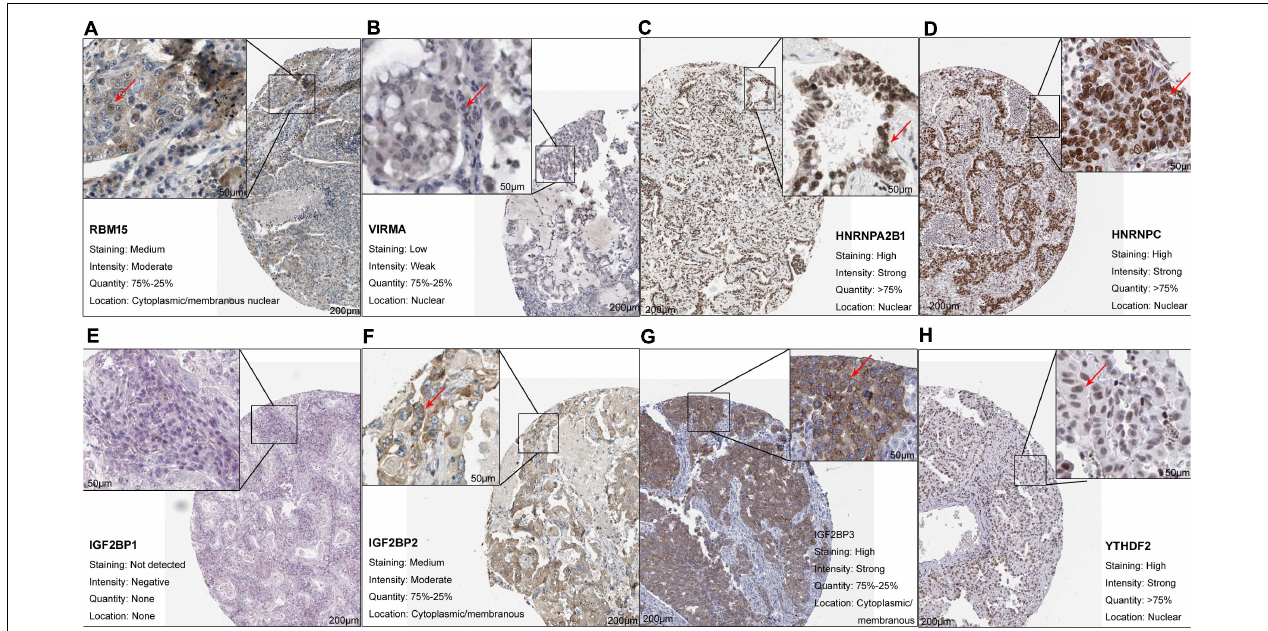
FIGURE 2 | Upregulation of m6A-related genes in lung adenocarcinoma. (A) RBM15 (antibody CAB015201, patient 3003), (B) VIRMA (antibody HPA031530, patient 1847), (C) HNRNPA2B1 (antibody CAB012403, patient 2222), (D) HNRNPC (antibody CAB075755, patient 1932), (E) IGF2BP1 (antibody HPA062273, patient 3144), (F) IGF2BP2 (antibody CAB017126, patient 1394), (G) IGF2BP3 (antibody HPA076951, patient 4208), and (H) YTHDF2 (antibody HPA059621, patient